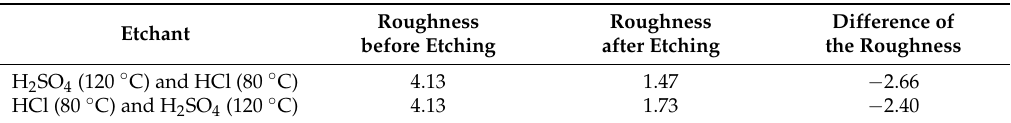
Table 8. The surface roughness of Ti-6Al-4V ELI after sandblasting and etching in dual acid by using white-light interferometry.